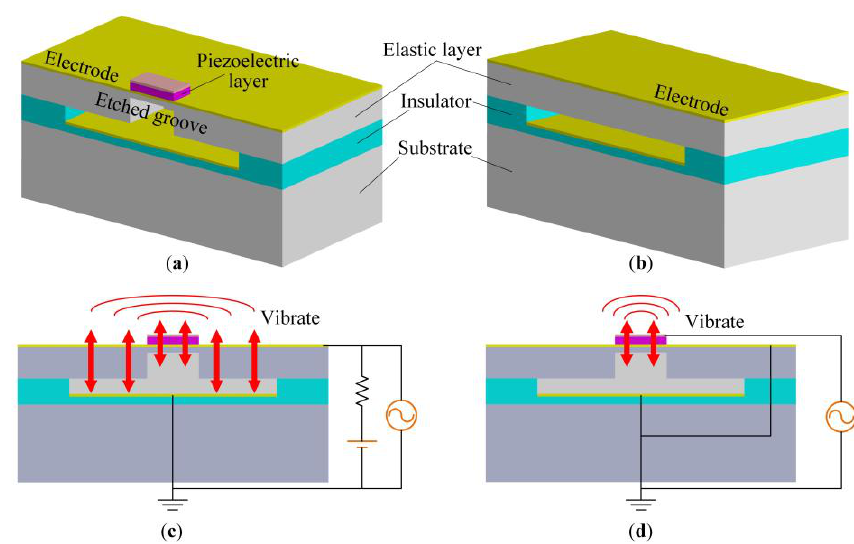
Figure 1. 3D schematic structure (cross-sectional view) and operation modes, ( a ) the capacitive-piezoelectric hybrid DFUT; ( b ) one conventional CMUT for reference; ( c ) the low-frequency CMUT excitation form; ( d ) the high-frequency PMUT excitation form.